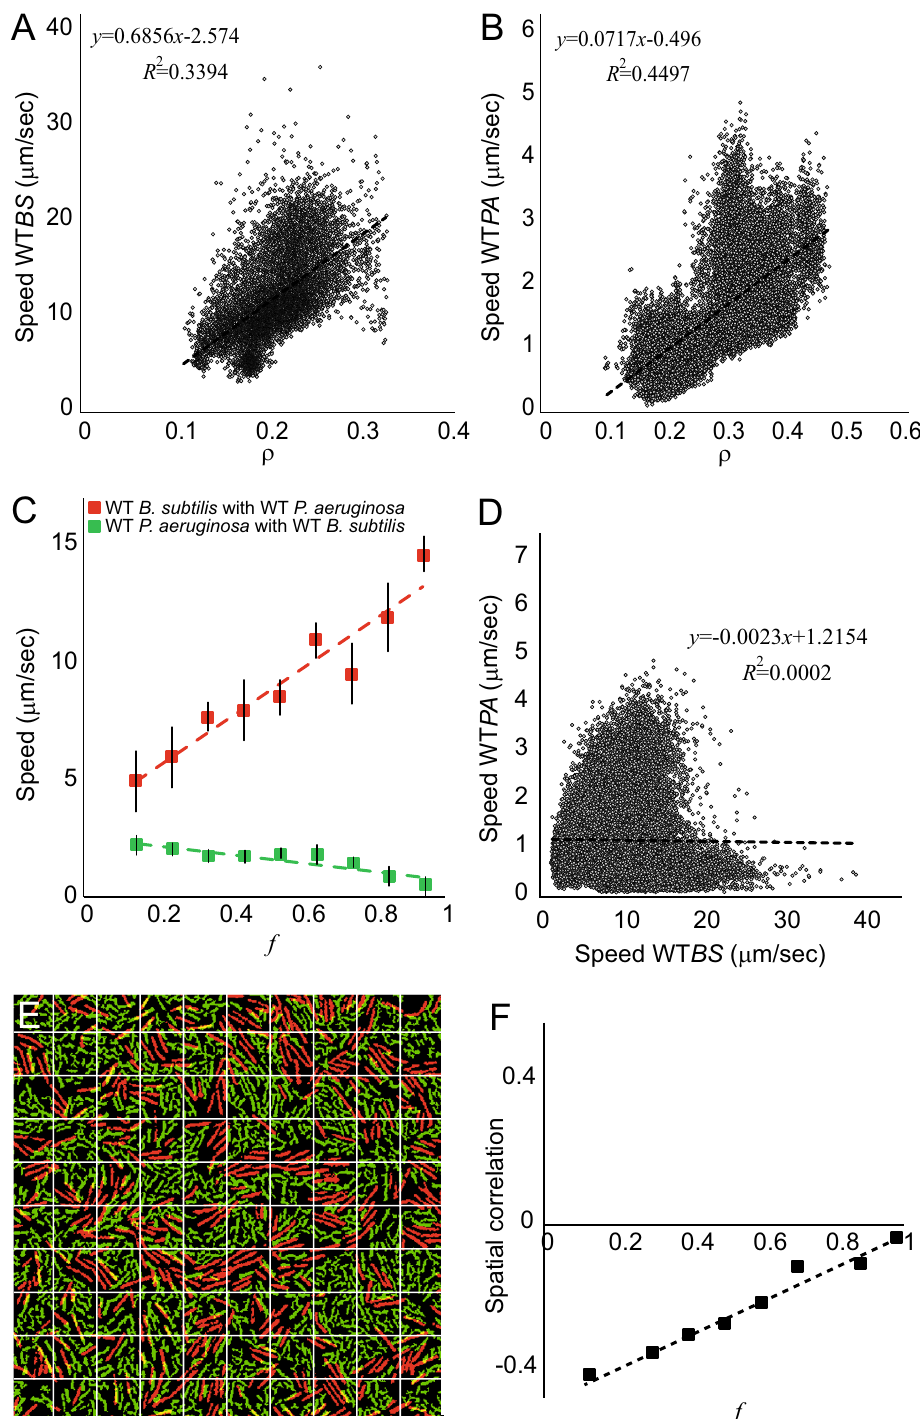
Figure 2. Dynamics analyses of mixed WT swarm colonies. ( A ) The speed of WT B. subtilis as a function of ρ (pooled over all f ). The speed increases with the total cell density. ( B ) The speed of WT P. aeruginosa (pooled over all f ) . The speed increases with the total cell density. ( C ) The average speed of the WT B. subtilis (red) is an increasing function of the density ratio f at fixed area fraction ρ = 0.25. The average speed of the WT P. aeruginosa (green) is a decreasing function of the density ratio f (the partial density of B. subtilis ). The average is taken over different experiments and the error bars are standard deviations between experiments. Dashed lines are linear regressions. ( D ) The speed of P. aeruginosa as a function of the speed of B. subtilis , pooled overall ρ and f , shows no correlation. ( E ) Dividing the frame into equally-sized bins, then ( F ) calculating the spatial correlation between the area fraction of the two species as a function of f . The dashed line is a linear